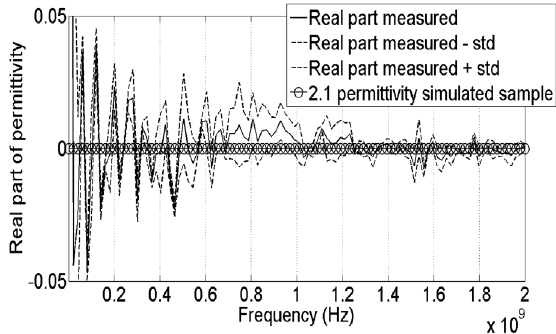
Figure 12. Imaginary part of the permittivity of Teflon measured and simulated for the probe with core radius a = 1.2 mm.